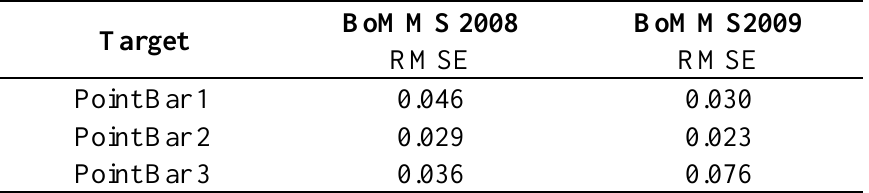
Table 3. BoMMS 2008 and BoMMS 2009 DEM accuracies for point bars after